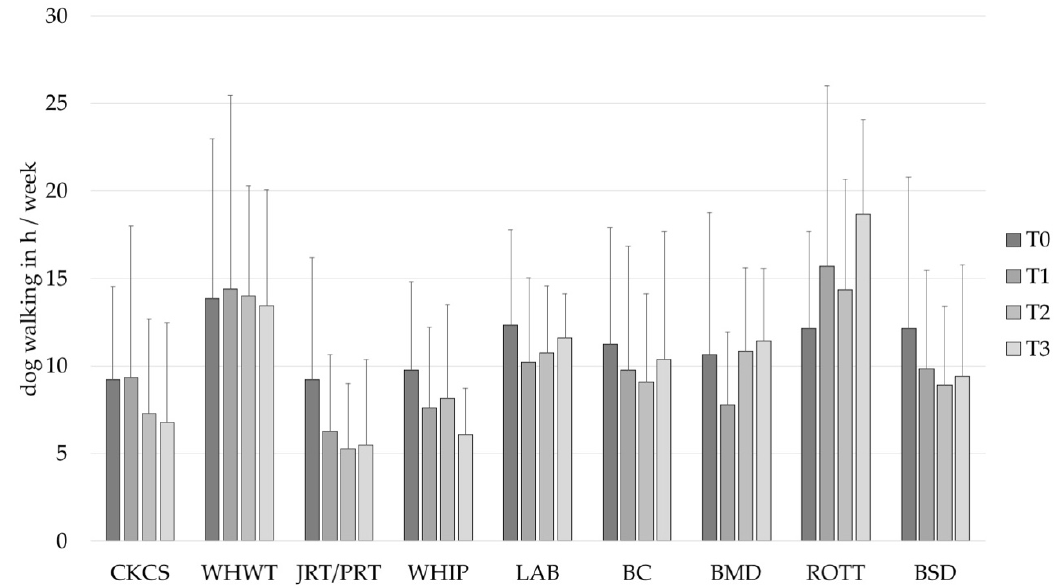
Figure 3. Dog walking in h/week (mean ± SD ) of owners of different dog breeds at baseline (T0), after 1 (T1), 2 (T2) and 3 (T3) years. BC, Border Collie; BERN, Bernese Mountain Dog; BSD, Belgian Shepherd Dog; CKCS, Cavalier King Charles Spaniel; JRT/PRT, Jack and Parson Russell Terrier; LAB, Labrador Retriever; ROTT, Rottweiler; WHIP, Whippet; WHWT, West Highland White Terrier.